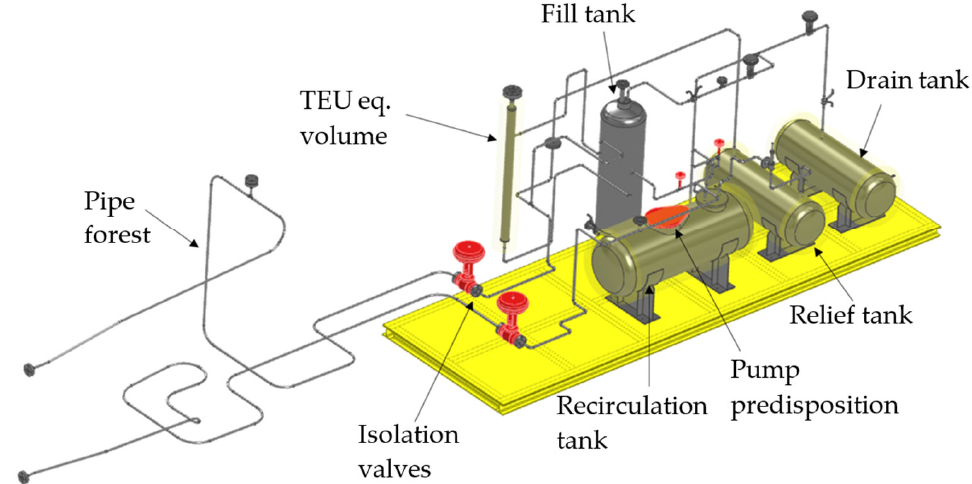
Figure 4. LIFUS5/Mod4 preliminary CAD drawing. Highlighted in red: the isolation valves and the upgrade points.